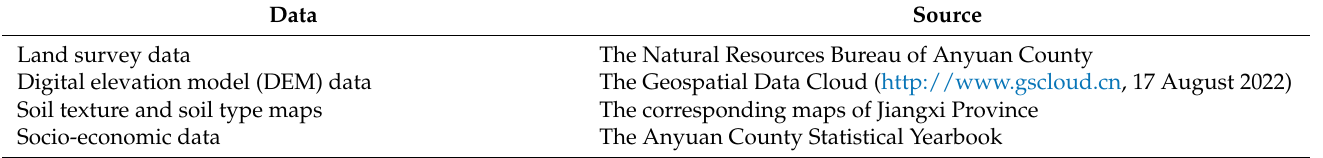
Table 1. Table of data sources.